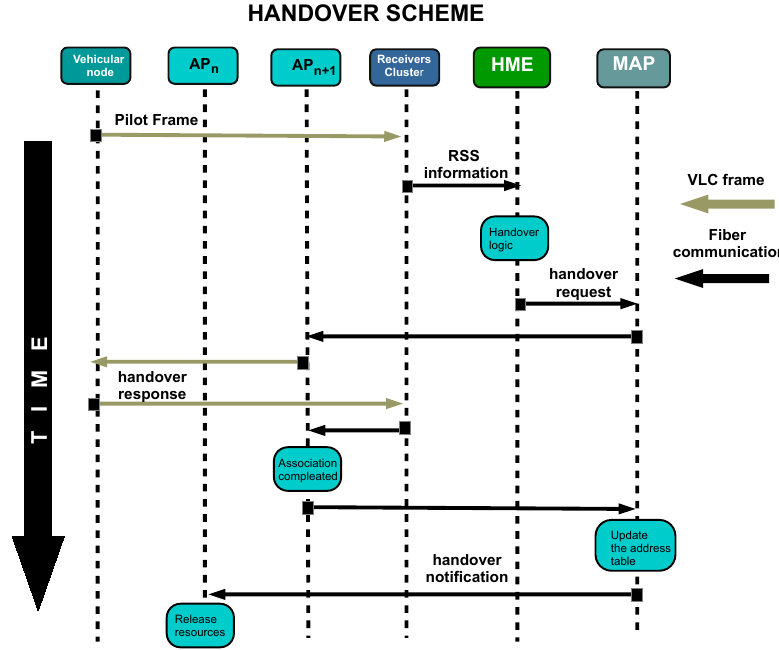
Figure 9. Handover execution